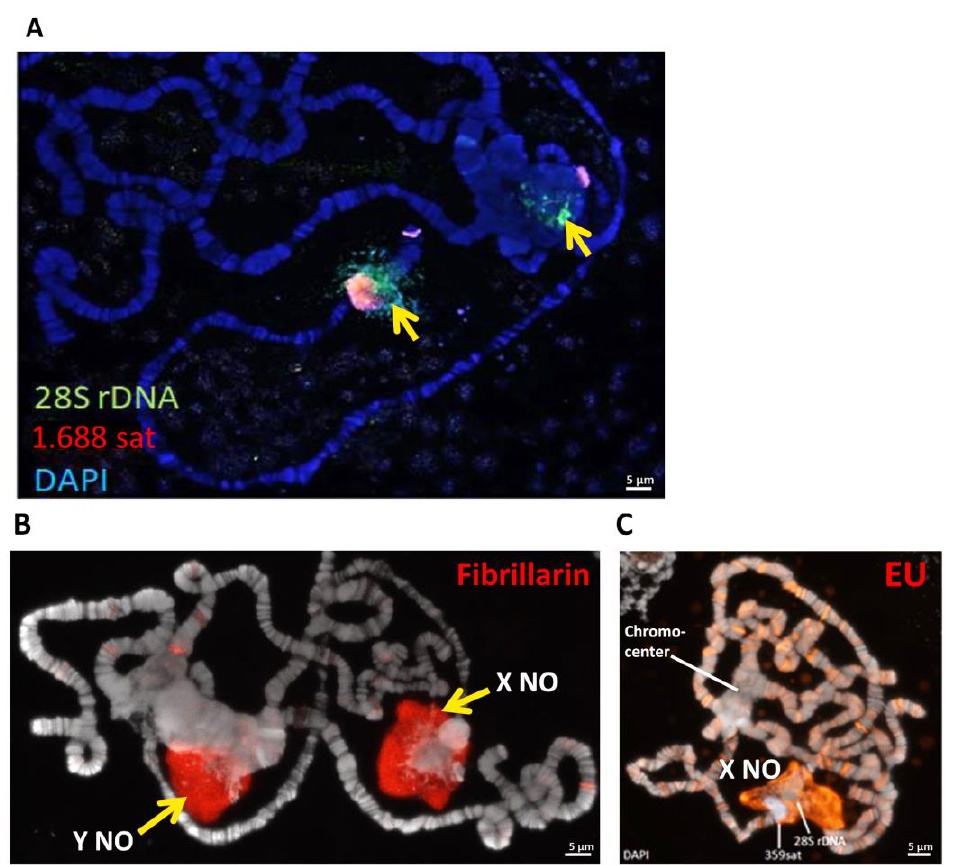
Figure 8. Detection of X- and Y-chromosome nucleoli in polytene chromosomes of In(1)sc 8 + 19EHet ; Rif1 1 male larvae. ( A ) FISH of 28S rDNA (green) and 1.688 satellite (red) probes. A large block of 1.688 satellite marks X-chromosome heterochromatin removed from the chromocenter by In(1)sc 8 + 19EHet . Two rDNA clusters can be seen (arrows). ( B ) An example of two active nucleoli visualized by fibrillarin immunostaining. ( C ) An example of an active X chromosome nucleolus and an inactive Y chromosome nucleolus visualized by EU pulse incorporation.